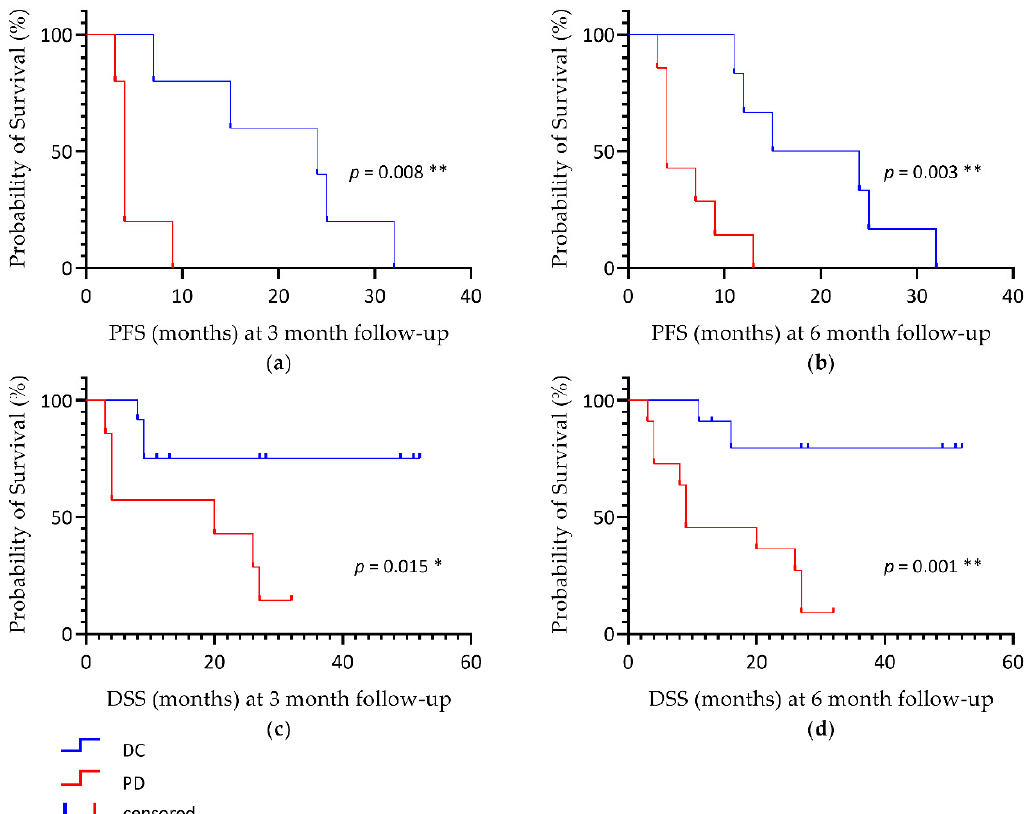
Figure 3. Kaplan-Meier estimate of PFS ( a , b ) and DSS ( c , d ) according to mPERCIST criteria for 3 and 6 month follow-up imaging. PFS, progression-free survival; DSS, disease-specific survival; DC, disease control; PD, progressive disease; * p -value < 0.05; ** p -value < 0.01.